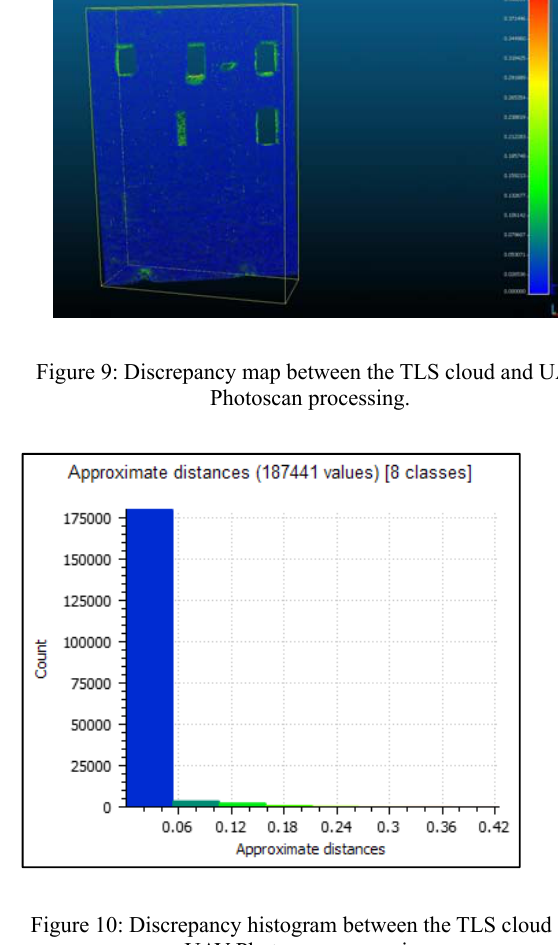
Figure 10: Discrepancy histogram between the TLS cloud and UAV Photoscan processing.